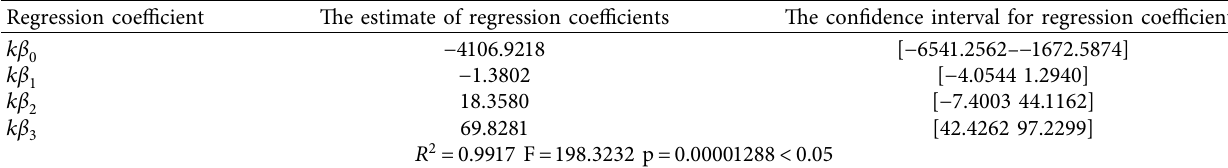
Table 3: Results of multiple linear processing on the data.